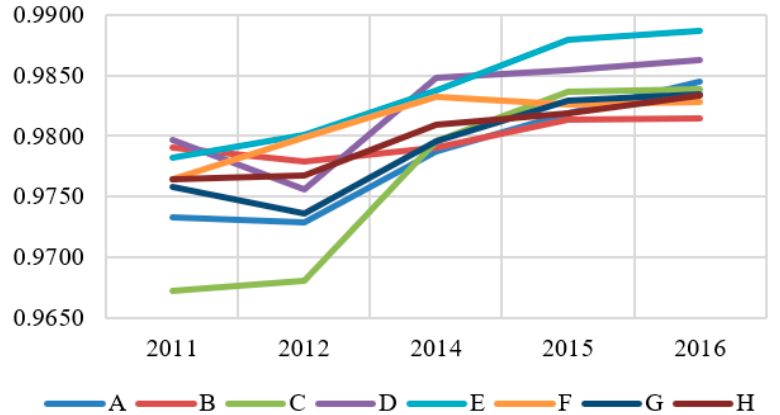
Figure 4. The average value of the technical readiness rate for the analysed road freight transport enterprises in the years 2011–2016.